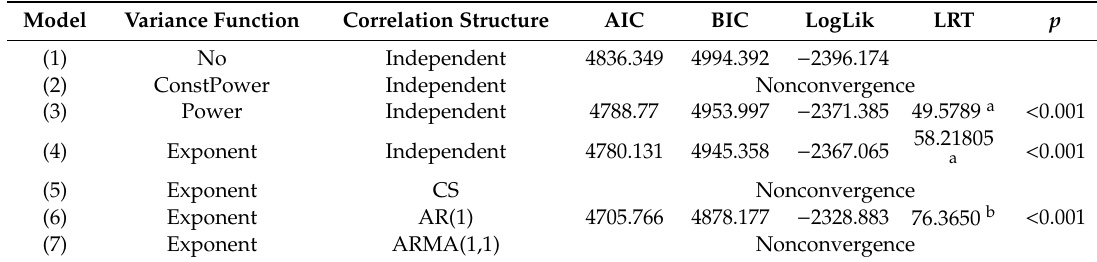
Table 4. The lack-of-fit statistics of the linear mixed-e ff ects individual-tree basal area increment model using di ff erent error variance–covariance